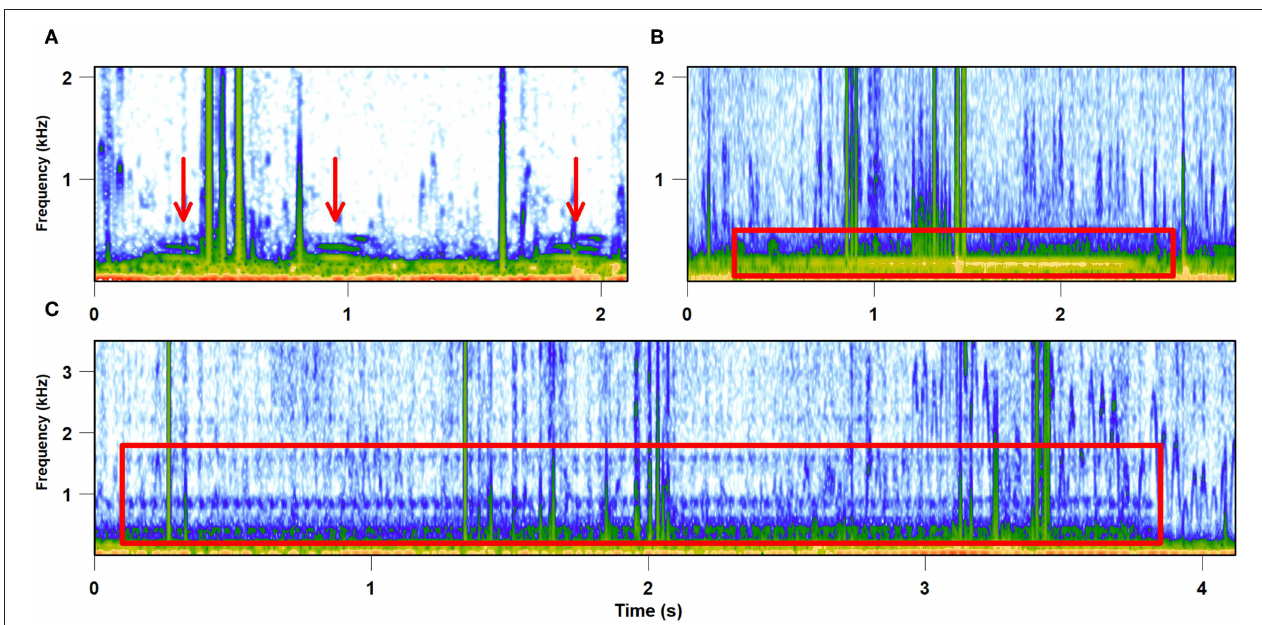
FIGURE 3 | Vibrational signals recorded from spider web. Vibrations were recorded on July 27, 2017 with a laser vibrometer from the web of Argiope bruennichi built between several grass stems. (A,B) Vibrational signals of two unknown species, (C) male advertisement call of the leafhopper Aphrodes makarovi